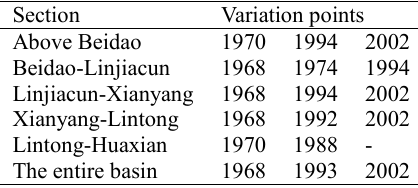
Table 4 Sliding t-test results.